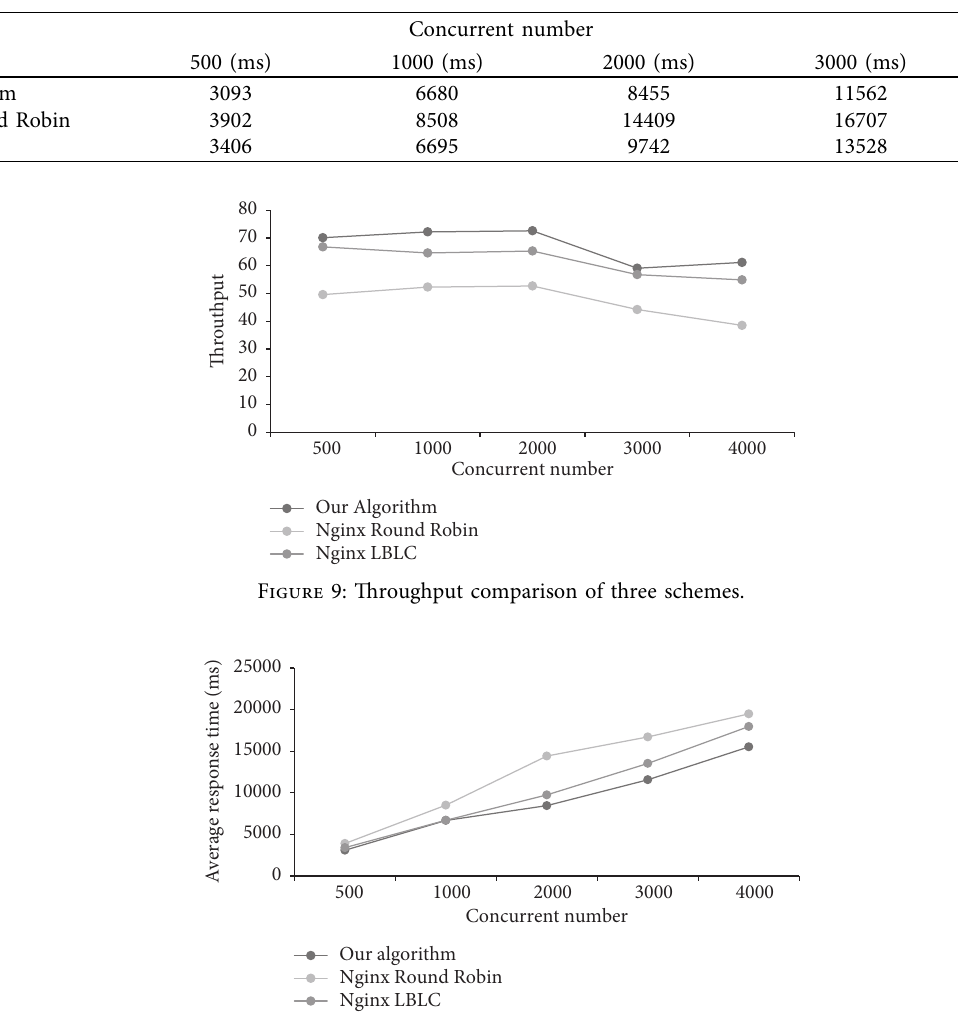
Table 6: Average response time comparison of three front-end server solutions.